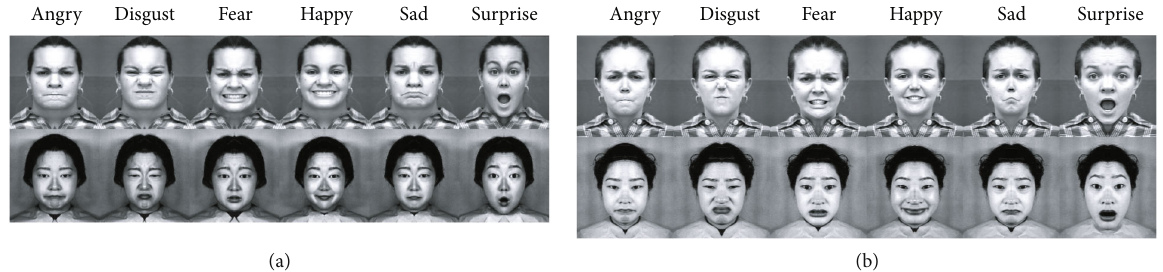
Figure 4: Sample reconstructed face images with varying expressions: (a) sample of left reconstructed face image with varying expressions; (b) sample of right reconstructed face image with varying expressions.